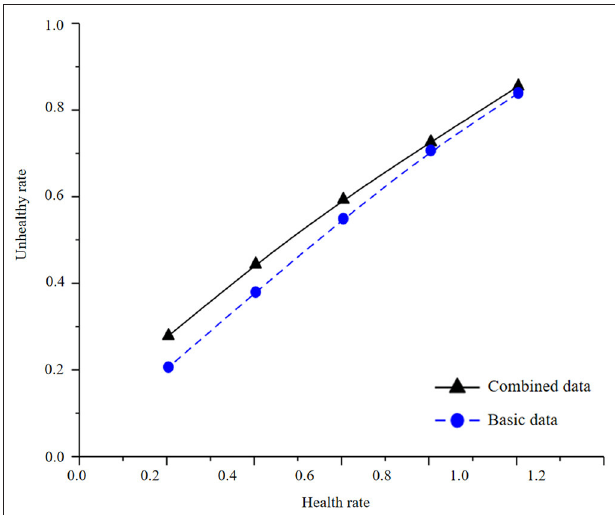
FIGURE 3 | Health information statistics of logistic regression combined data and basic